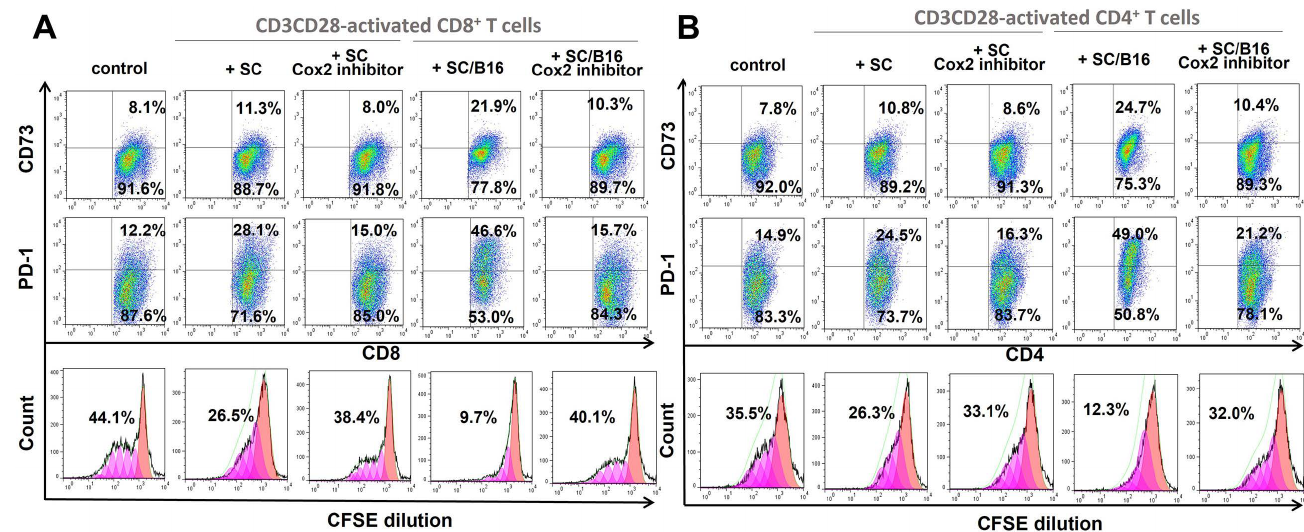
Figure 3. COX-2 inhibition prevented T cell exhaustion induced by tumor-activated SC. Adult SC were isolated from the sciatic nerve of C57BL/6 mice, cultured and purified as described in M&M. SC were then co-cultured with medium (SC) and B16-conditioned medium (10% v / v ) (SC/B16) for 24 h after pretreatment with COX-2 inhibitor CAS 181696-33-3 (10